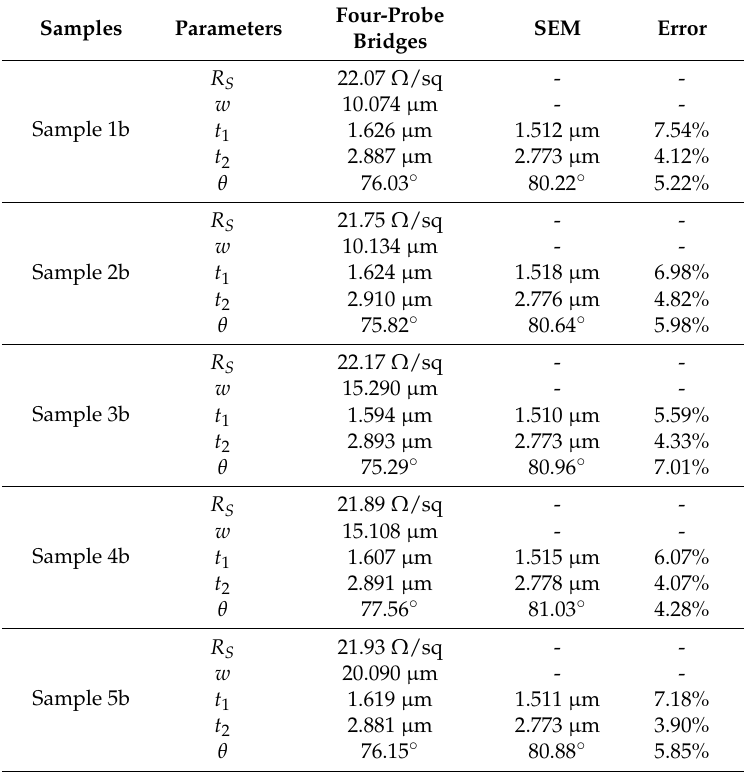
Table 2. Experimental results of Poly 2 layer and stacked Oxide 1-Oxide 2